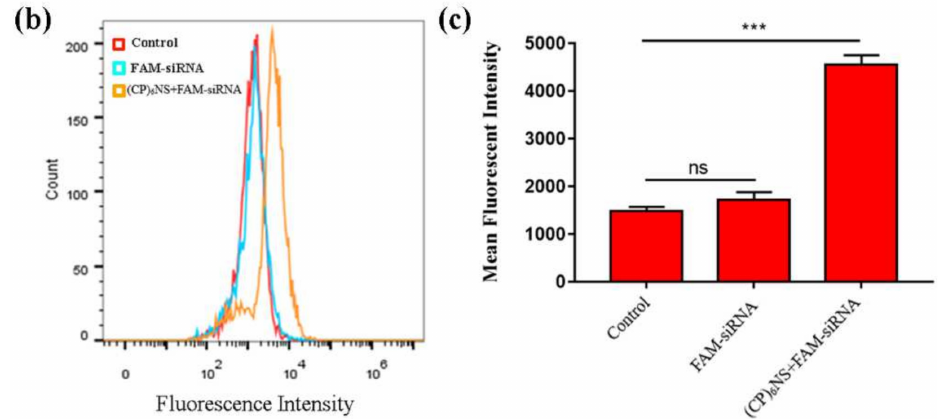
Figure 6. Internalization of (CP) 6 NS-siRNA into MDA-MB-231 cells. ( a ) CLSM images of MDA-MB-231 table. ( c ) Mean fluorescence intensity statistics. Each value is expressed as the mean ± SD ( n = 3).